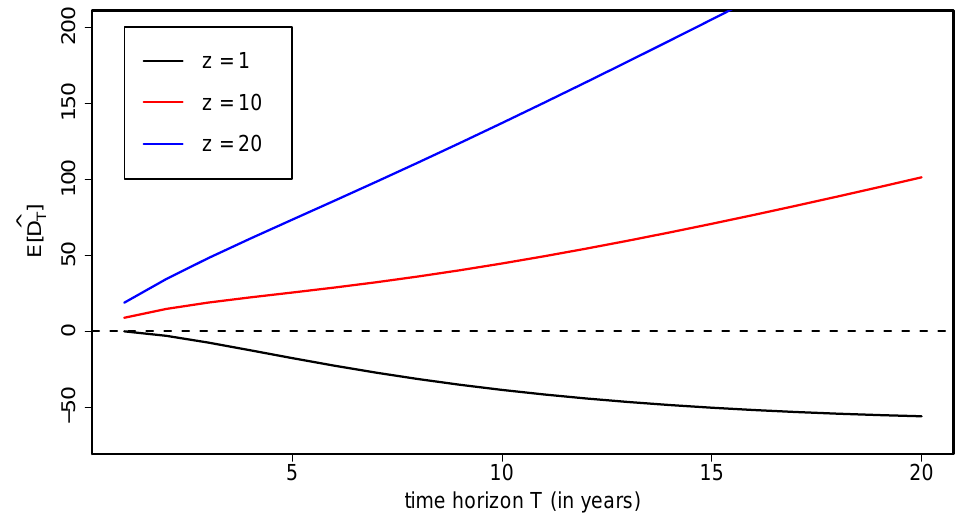
D T ] as a function of the claim payment (cid:98)